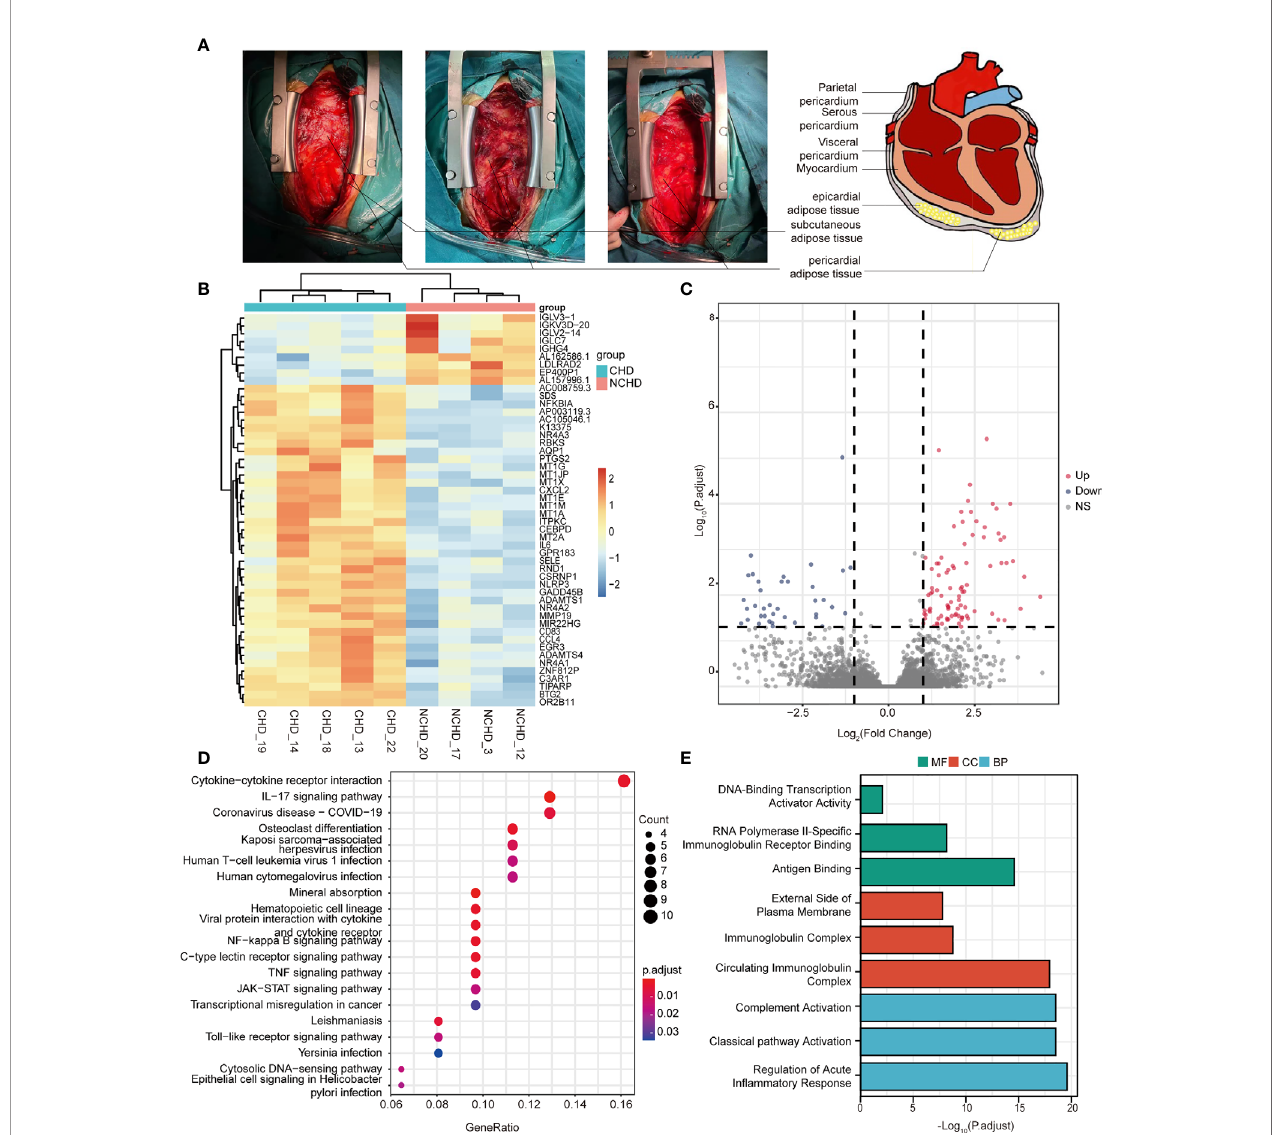
FIGURE 1 | (A) Localization of pericardial fat; (B) Heatmap results of DEGs; (C) Volcano plot results of DEGs; (D, E) The signi fi cantly enriched KEGG and GO terms that correspond to coding gene functions of upregulated and downregulated